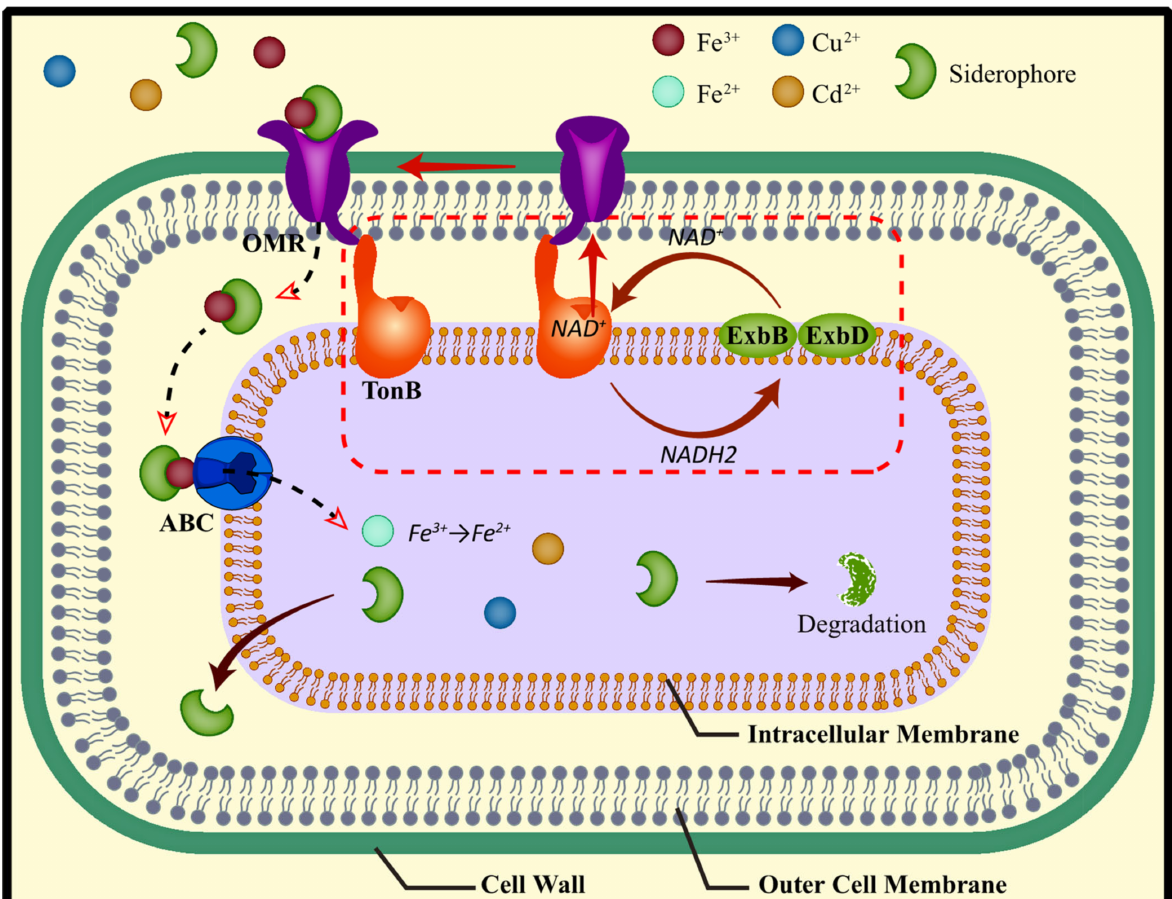
Figure 3. Mechanism of siderophore chelation of metals. Each metal-siderophore complex is rec- ognized by a specific outer membrane receptor (OMR), and the complex is transported into the intracellular membrane by the transporter ABC, where the metal ion is converted to a less toxic ionic form. When the siderophore mission is completed, it will be degraded or transported to the cell wall for standby. The OMR interacts with the inner membrane proteins TonB, ExbB, and ExbD to facilitate the uptake of metal-siderophore